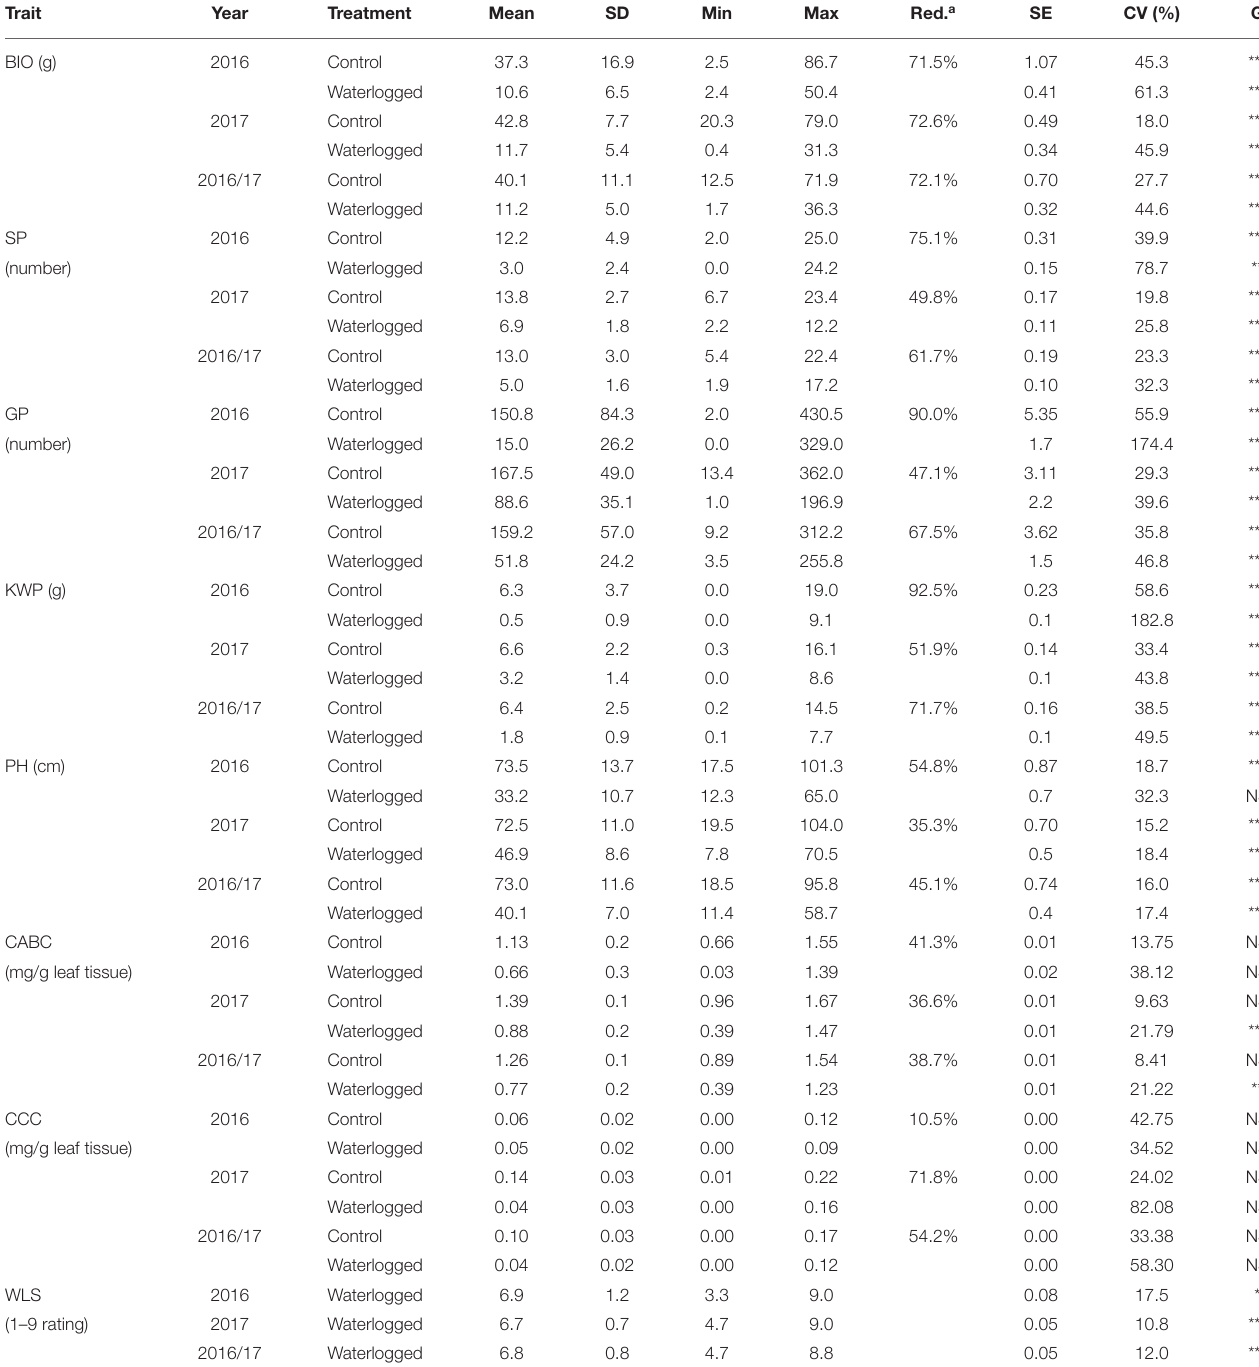
TABLE 1 | Mean values and standard deviations of waterlogging-related traits observed under control and waterlogging treatment in field conditions for 247 spring barley genotypes.